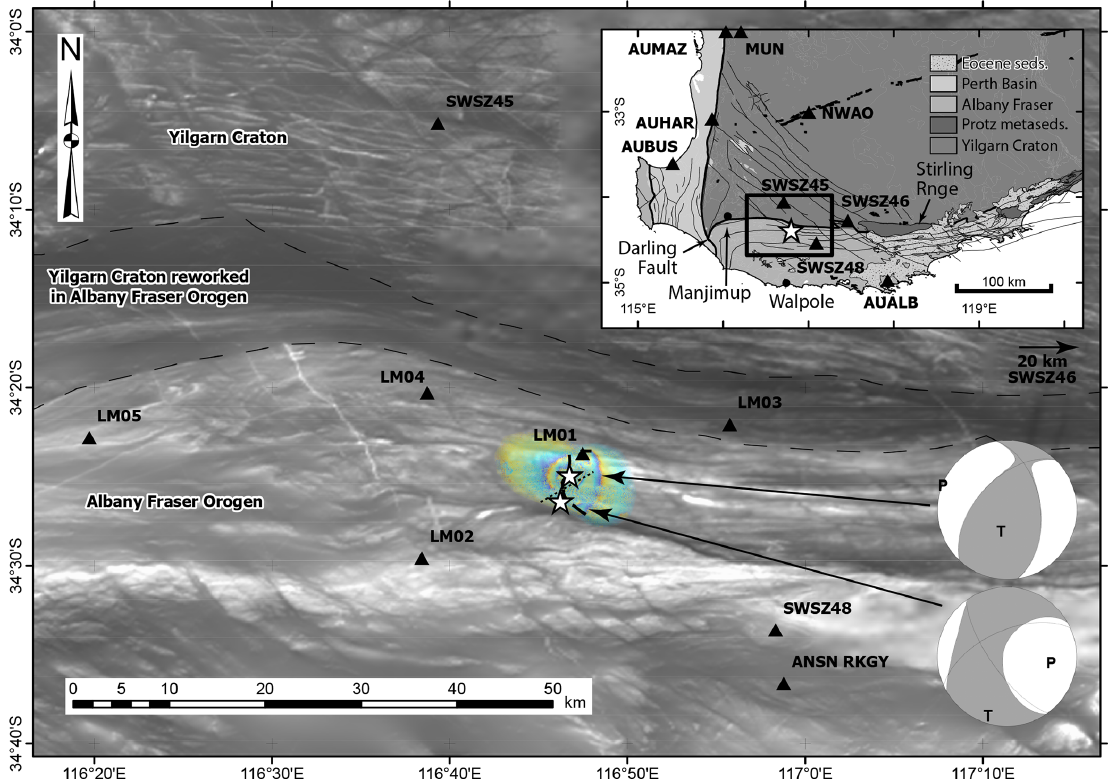
Figure 2. Location and geological setting of the 2018 Lake Muir earthquake sequence in southwest Western Australia. Inset shows Precam- brian basement geology and overlying Phanerozoic Perth Basin and Eocene rocks (modified after Geological Survey of Western Australia, 2016). Proterozoic and younger faults and dikes are shown as thick and thin black lines, respectively. Base map in the main frame shows reduced-to-pole total magnetic intensity data (Milligan and Nakamura, 2015). Black triangles show the locations of seismic recording sta- tions (rapid deployment kits are prefixed with LM) and GPS stations (SWSZ prefix). The location of the two M > 5 earthquake epicentres are shown by white stars, with arrows indicting the associated focal mechanisms (see Table 2 for source). The surface rupture trace from the September event and the surface deformation front from the November event are shown by solid and dashed black lines, respectively (see text for details). The InSAR phase image for the September M w 5.3 earthquake is overlain to demonstrate the scale of surface